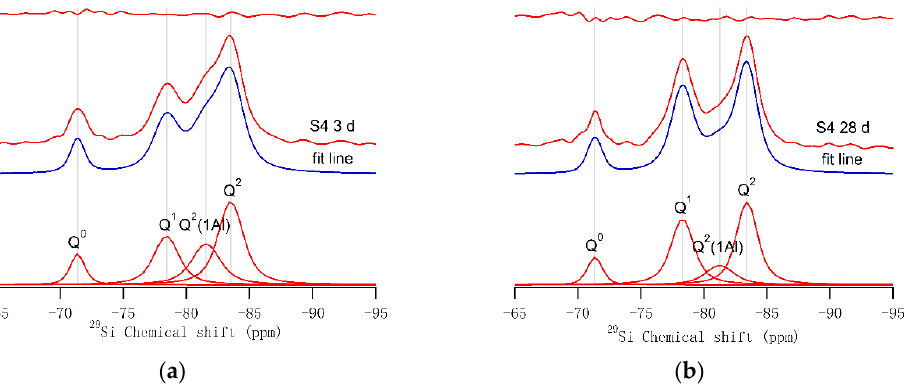
Figure 5. 29 Si magic angle spinning (MAS) nuclear magnetic resonance (NMR) spectra of ( a ) S4 after 3 days and ( b ) S4 after 28